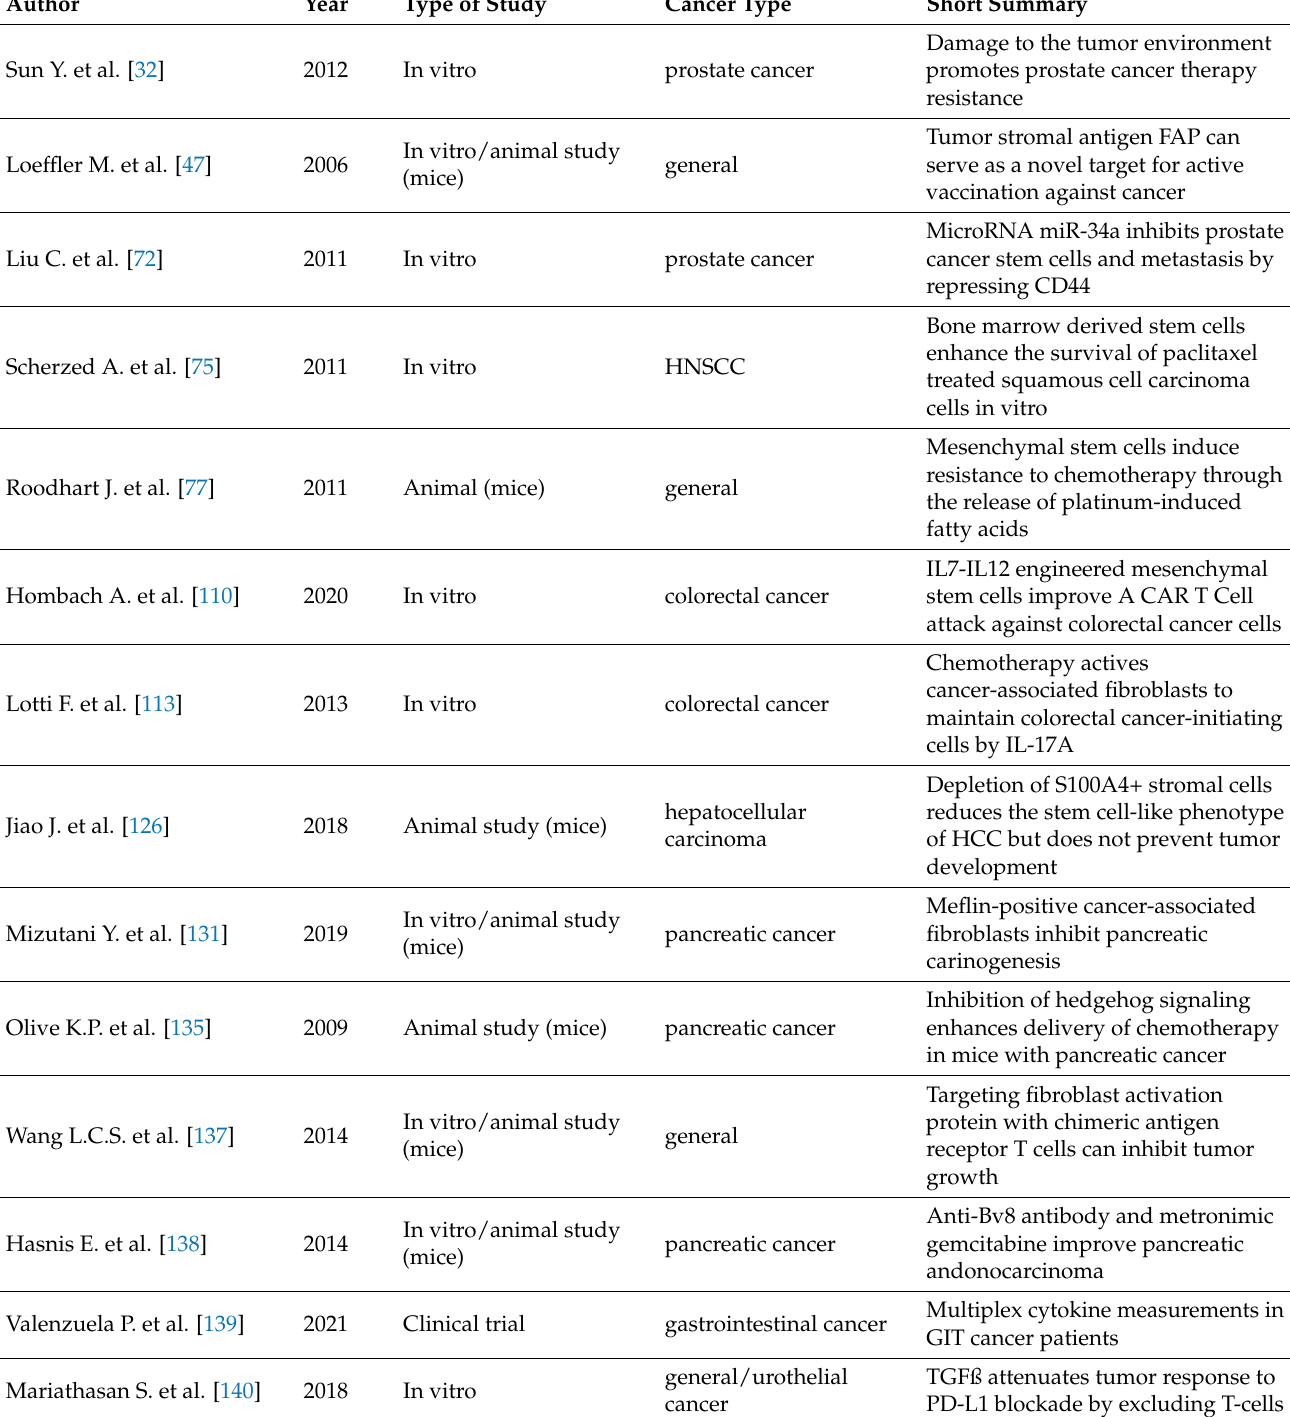
Table 3. Overview of selected studies targeting stroma cells, indicating the type of study and the type of tumor